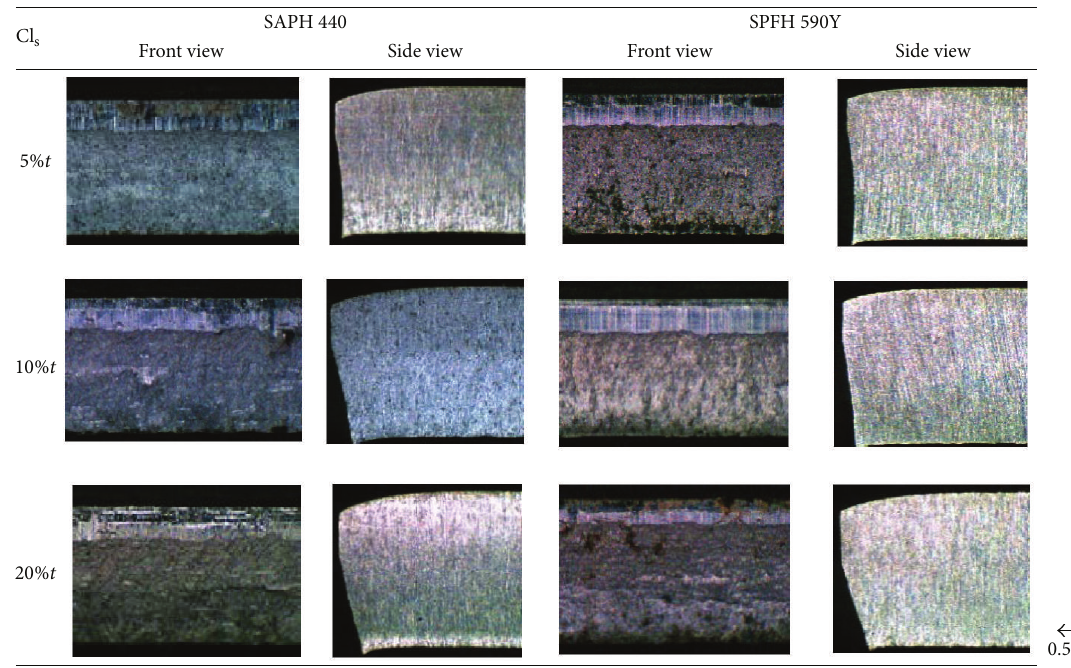
Figure 3: An example of cut surface after shearing process of high-strength steel sheet.